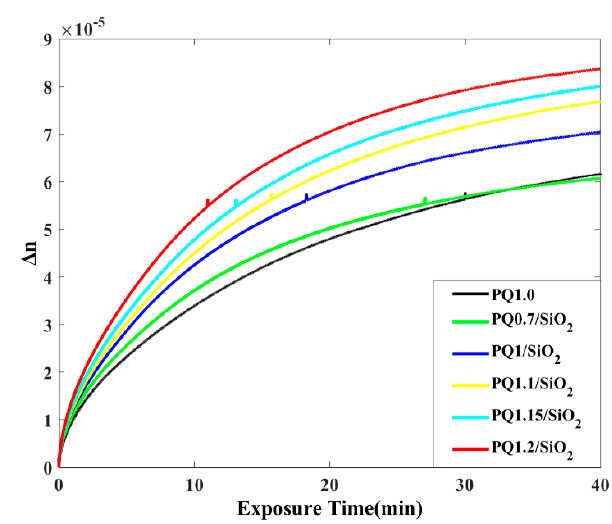
Figure 7. Temporal evolution of photoinduced birefringence.